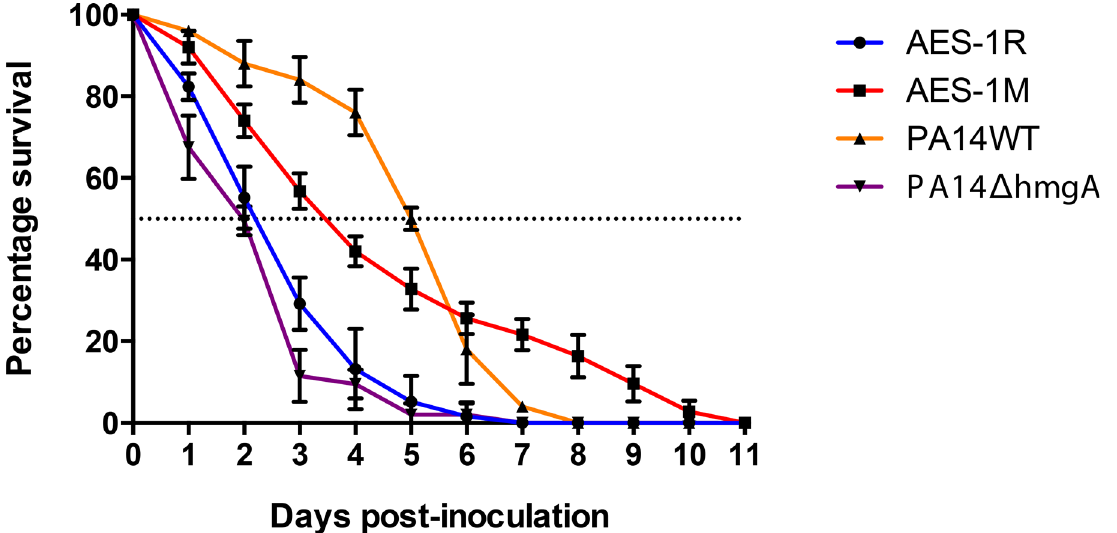
Fig 1. C . elegans virulence assay. Percent survival of C . elegans (n = 50) when grown on a lawn of P . aeruginosa AES-1R, AES-1M, PA14 and PA14 Δ hmgA . The dotted line indicates the LT 50 (mean time at which 50% of the worms were killed by ingesting P . aeruginosa ). The individual points are the means of six biological replicates for AES-1 stains and three biological replicates for PA14 strains. The error bars represent the standard error of the means.